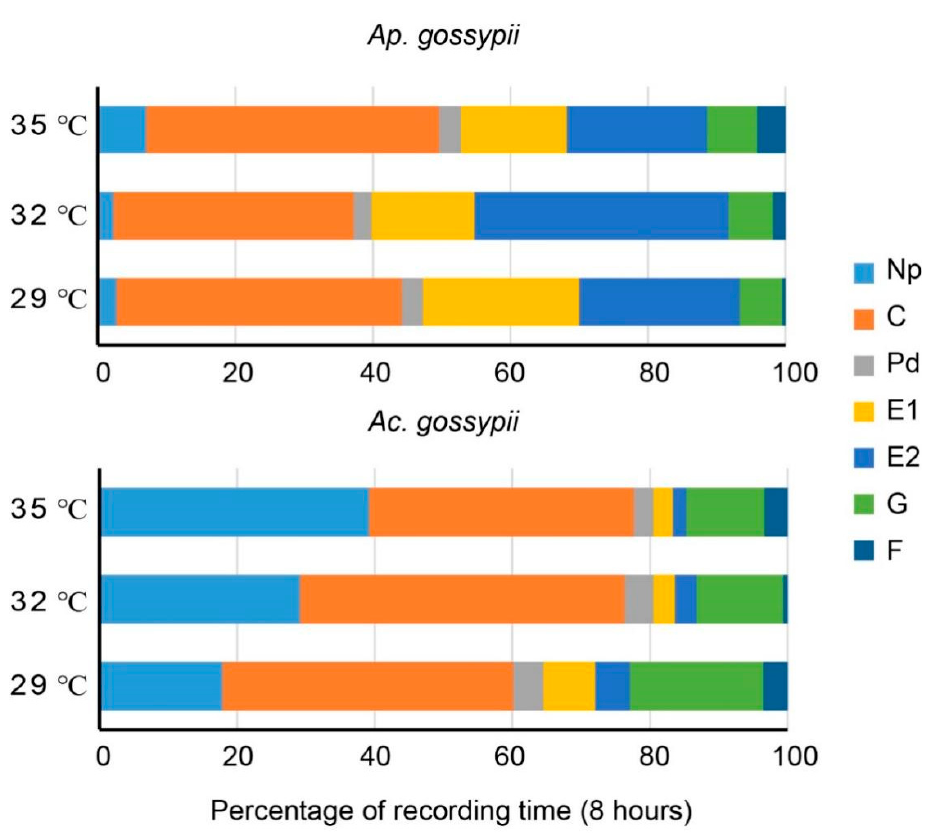
Figure 4. Proportional duration of various waveforms of Aphis gossypii and Acyrthosiphon gossypii behavior at different temperatures during an 8 h EPG recording. EPG waveforms are as Np = non- probing/penetration; C = pathway waveform; Pd = potential drop; E1 = salivary secretion; E2: phloem sap ingestion; G = xylem feeding; F = mechanical penetration difficulties.